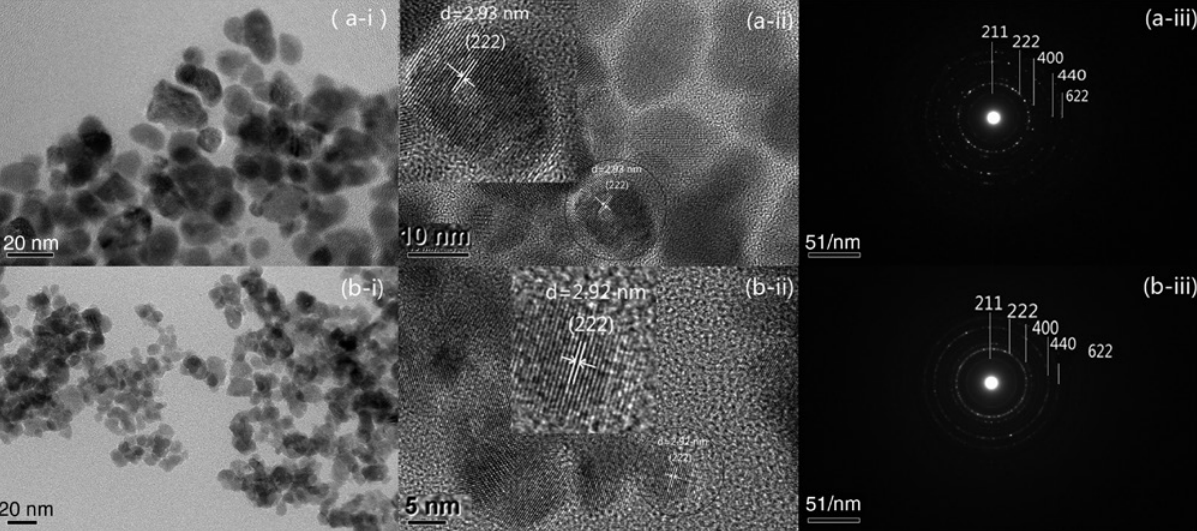
O nanoparticles prepared by annealing in (a) Ar and (b) 2 3